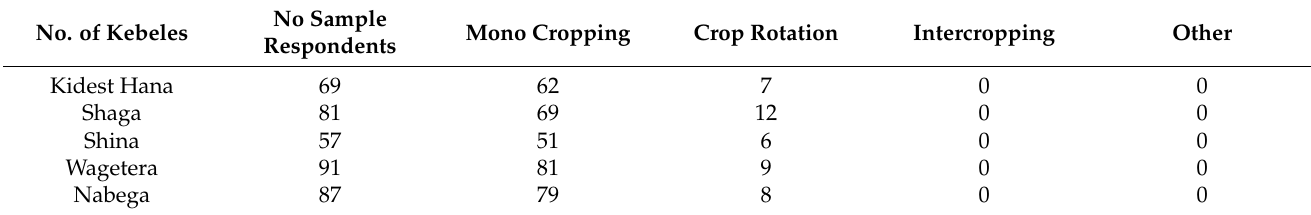
Table 4. Types of cropping pattern.